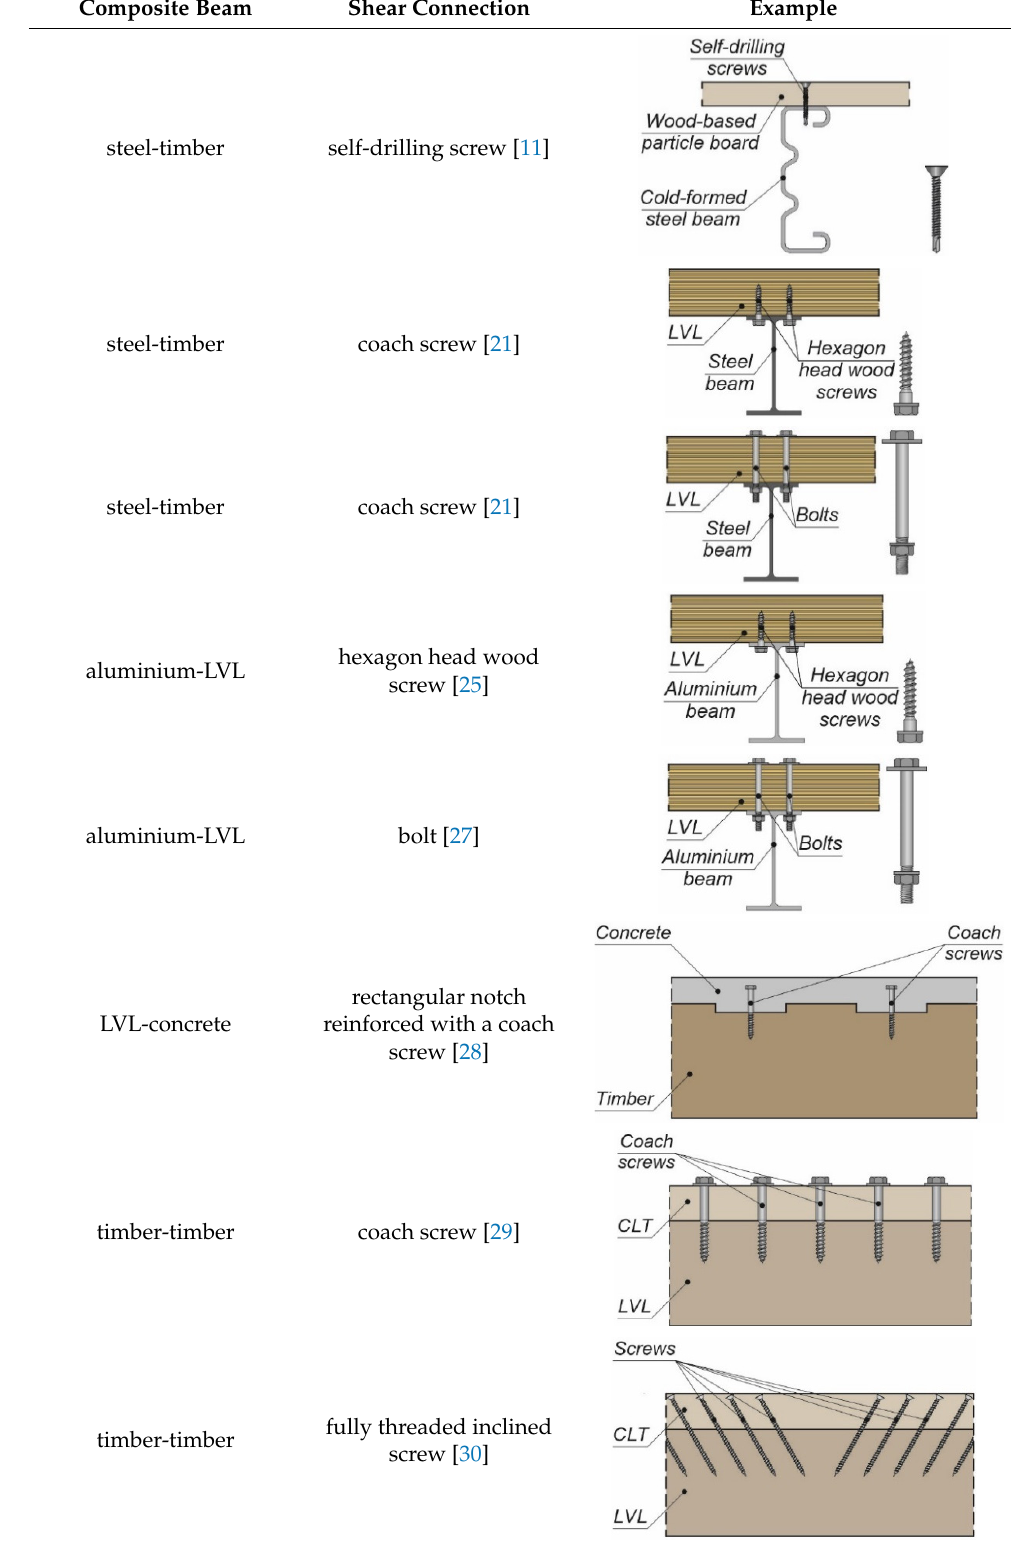
Table 1. Shear connections used in composite beams with timber elements.